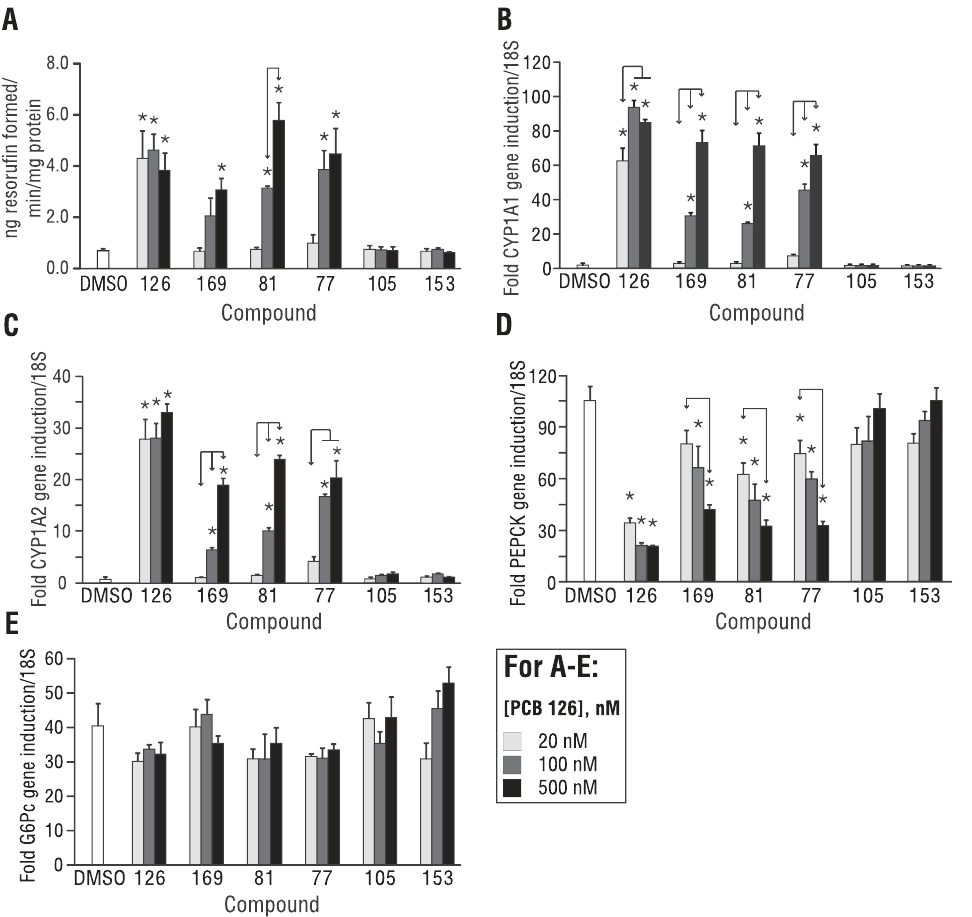
Figure 6. Other dioxin-like PCBs that activate AhR suppress PEPCK gene induction. (A) Dioxin-like PCBs 126, 169, 81, and 77 induce EROD activity, with dose-dependency for all dioxin-like PCBs with the exception of PCB 126. (B) Similar trends observed for when CYP1A1 was used as the readout instead of EROD. (C) CYP1A2 gene expression demonstrates a pattern in line with observations made in panels A and B. (D) Forskolin-induced PEPCK gene expression is suppressed by other dioxin-like PCBs in a dose-dependent fashion, with the exception of PCB 126. (E) G6pc gene induction is not affected by any tested PCBs at any tested concentration. *p , 0.05 vs. DMSO, significant differences between doses of PCBs are designated by arrows. Note: for clarity, the PCB prefix has been eliminated for the tested congeners on the x-axis label. Data are average of 2–3 experiments; error bars are 2 / + SD.